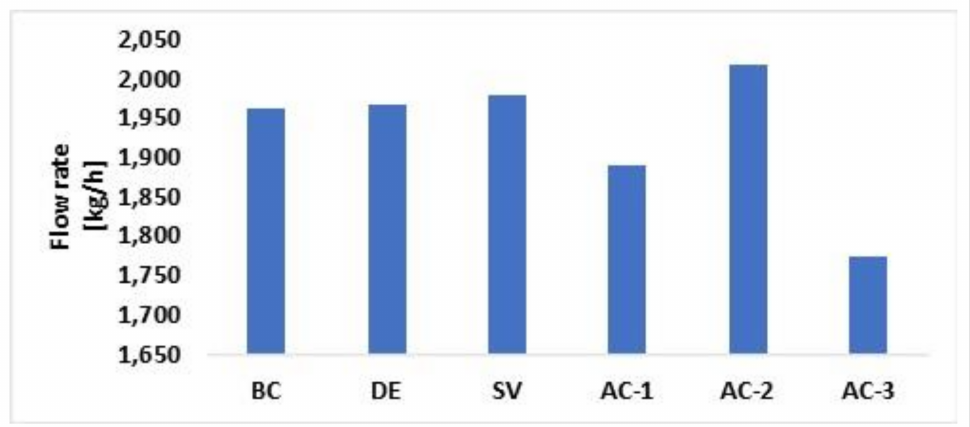
Figure 10. Maximum flow rate in the various